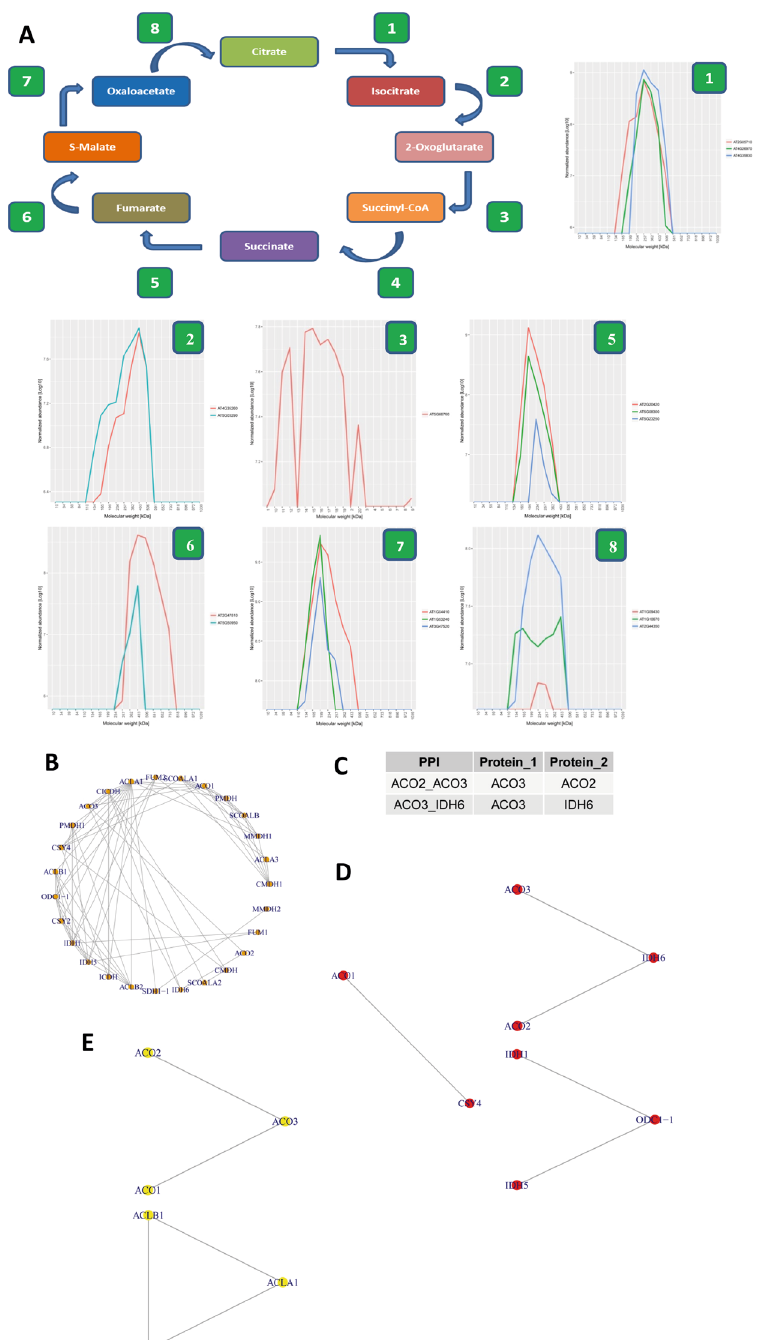
Figure 7. Using the TCA cycle as a scaffold to benchmark the identification of protein complexes. Using the KEGG database as a reference, a flow diagram of the TCA cycle was produced. In this diagram the enzymes that catalyse the individual substrate conversion reactions have been annotated as nodes. This flow diagram served as a scaffold wherein a comparison of the nodes was made to the ED dataset. It was possible to verify nearly all of the conversion reactions, with the exception of succinyl-CoA to to succinate. The enzymes involved in this step were not detected in any of the experimental replicates. Subsequently, the protein profiles of all detected enzymes at each individual node has been combined to visually illustrate power of our method to detect protein protein interactions. ( B ) Graphical overview of the PPI interaction network predicted for the TCA cycle using the ED data set. ( C ) The overlap between PPIs detected in the ED dataset and those identified by Zhang and colleagues are shown26. ( D ) Interactions identified between enzymes that catalyse consecutive reactions in the TCA cycle which were not reported by Zhang and colleagues26 ( E ) Predicted protein interactions within the enzyme protein complexes of aconitase (left) and ATP citrate lyase (right). Predicted interactions were observed using a Euclidean distance cutoff as predetermined using a ROC curve analysis (10% FDR). Enzymes and their isoforms are represented by nodes, while the edges connecting them show potential